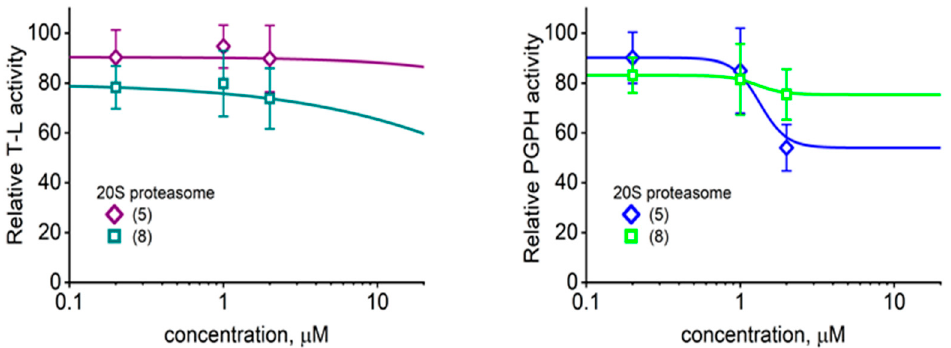
Figure 4. As demonstrated for (5) and (8), the TAT1 derivatives did not seem to significantly affect the post basic (trypsin-like; T-L) and post acidic (post glutamyl peptide hydrolyzing; PGPH) peptidase activities of the core proteasome. Means ± SD, n = 3–4. The control relative activities (100%) corresponded to 9.2 ± 1.4; n = 3 (T-L) and 3.1 ± 0.3; n = 4 (PGPH) nanomoles of the AMC (7-amino-4-methylcoumarin) product per mg of latent 20S per minute, respectively.